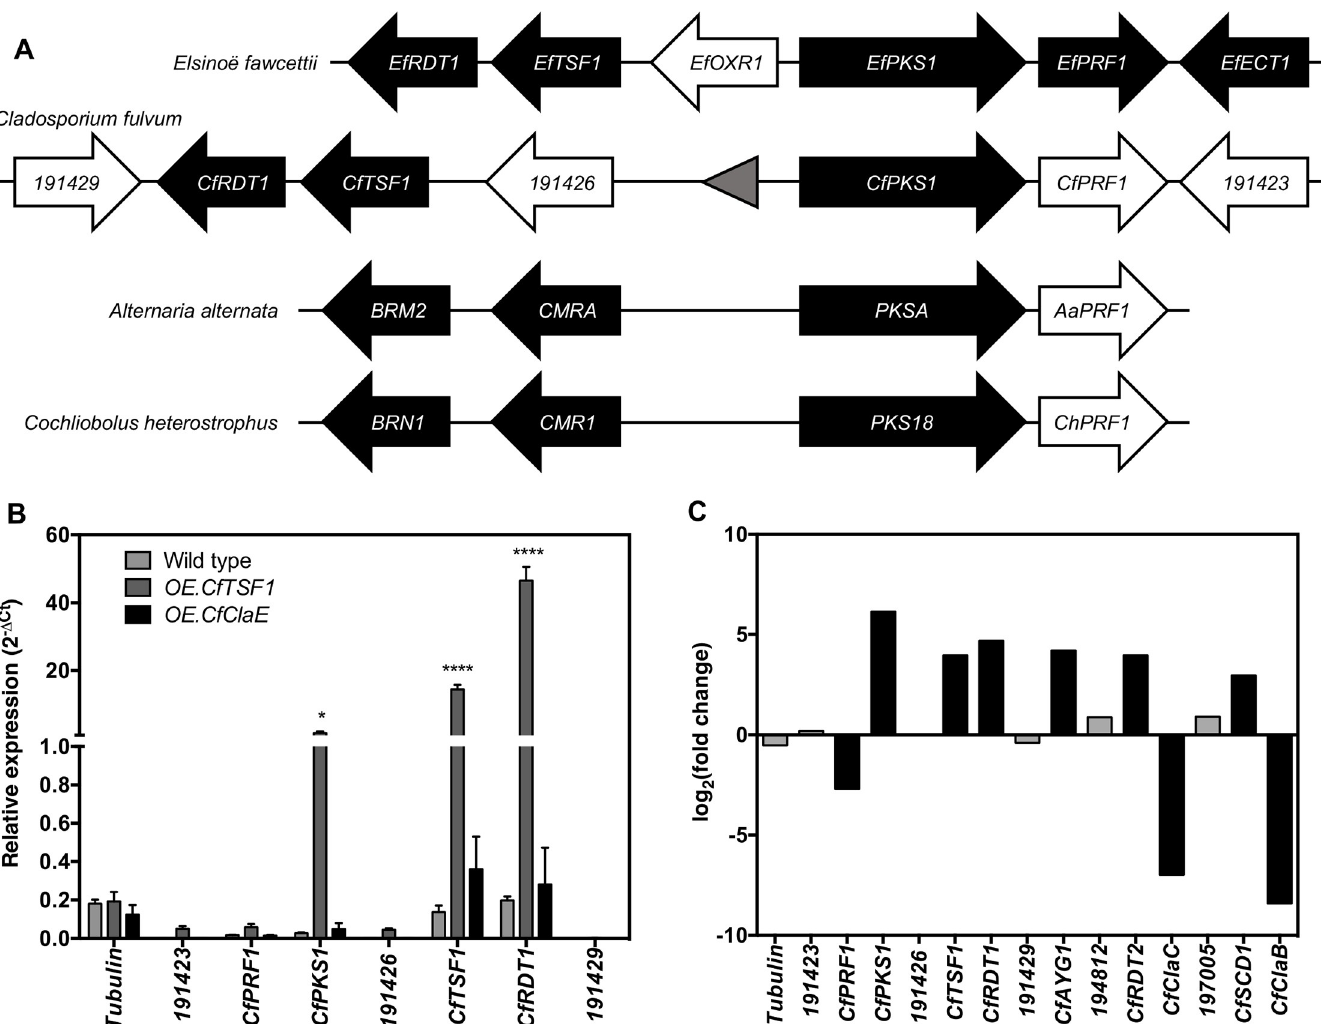
Fig 1. Definition of the CfPKS1 gene cluster in Cladosporium fulvum . (A) Organization of the predicted CfPKS1 gene cluster based on the reported homologous gene cluster in Elsinoe fawcettii [38,41].The locus of the DHN melanin gene cluster in Alternaria alternata and Cochliobolus heterostrophus is shown for comparison [32,33]. All loci contain a prefoldin-encoding gene downstream of the polyketide synthase gene. CMR1 and CMRA encode transcription factors that regulate the DHN melanin biosynthetic genes. BRN1 and BRM2 are 3-hydroxy naphthalene reductases homologous to RDT1 . Black arrows indicate co-regulated genes in each species, white arrows indicate non-co-regulated genes and the grey triangle indicate a transposable element. Loci are not drawn to scale. (B) Relative expression of genes at the CfPKS1 locus determined by reverse transcription-quantitative real-time polymerase chain reaction (RT-qrtPCR). Strain were pre-cultured in Potato Dextrose Broth (PDB) for five days before the biomass was transferred to B5 without nitrogen (B5-N) medium. After 48 hours, the biomass was recovered and used for RNA isolation and cDNA synthesis. The expression value for each gene within the CfPKS1 locus was measured in wild-type C . fulvum and inducible over-expression tranformants C . fulvum OE . CfTSF1 and OE . CfClaE [38] grown in B5-N medium. Expression values were normalised to actin and the average value was plotted with standard deviation between three biological replicates. A two-way ANOVA with a posthoc Sidak multicomparison test at the significance level of 0.05 was used to calculate statistically significant changes in gene expression between wild type and transformant strains. Asterisks ( � ) denote statistically significant changes ( p < 0.05 or less). (C) Differential expression of genes at the CfPKS1 locus and homologues of genes involved in the biosynthesis of DHN melanin in the Δ cfwor1 deletion mutant compared with the wild type as determined by RNA-seq [43]. Black and gray bars show significant and nonsignificant fold changes, respectively, according to Cuffdiff analysis of three biological repeats. https://doi.org/10.1371/journal.pone.0209600.g001 respectively, in the OE . CfTSF1 transformant than in wild type (each t-test P-value < 0.0001), whilst the predicted border genes are not co-regulated (Fig 1B). In contrast, CfPRF1 was not co-regulated and is therefore unlikely part of the CfPKS1 biosynthetic pathway. The up-regula- tion of the CfPKS1 gene cluster is specific to the over-expression of CfTSF1 because the gene